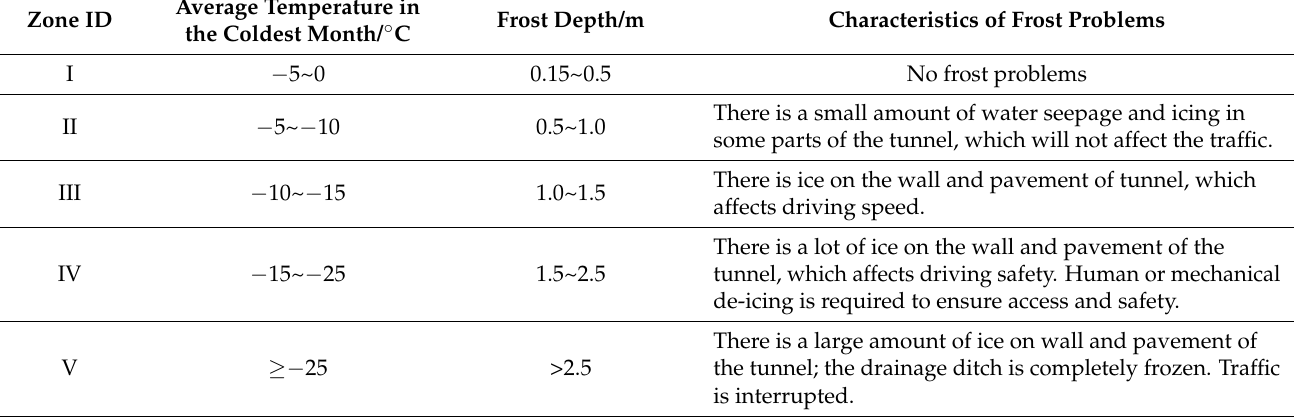
Table 6. Sub-regions of tunnels in cold